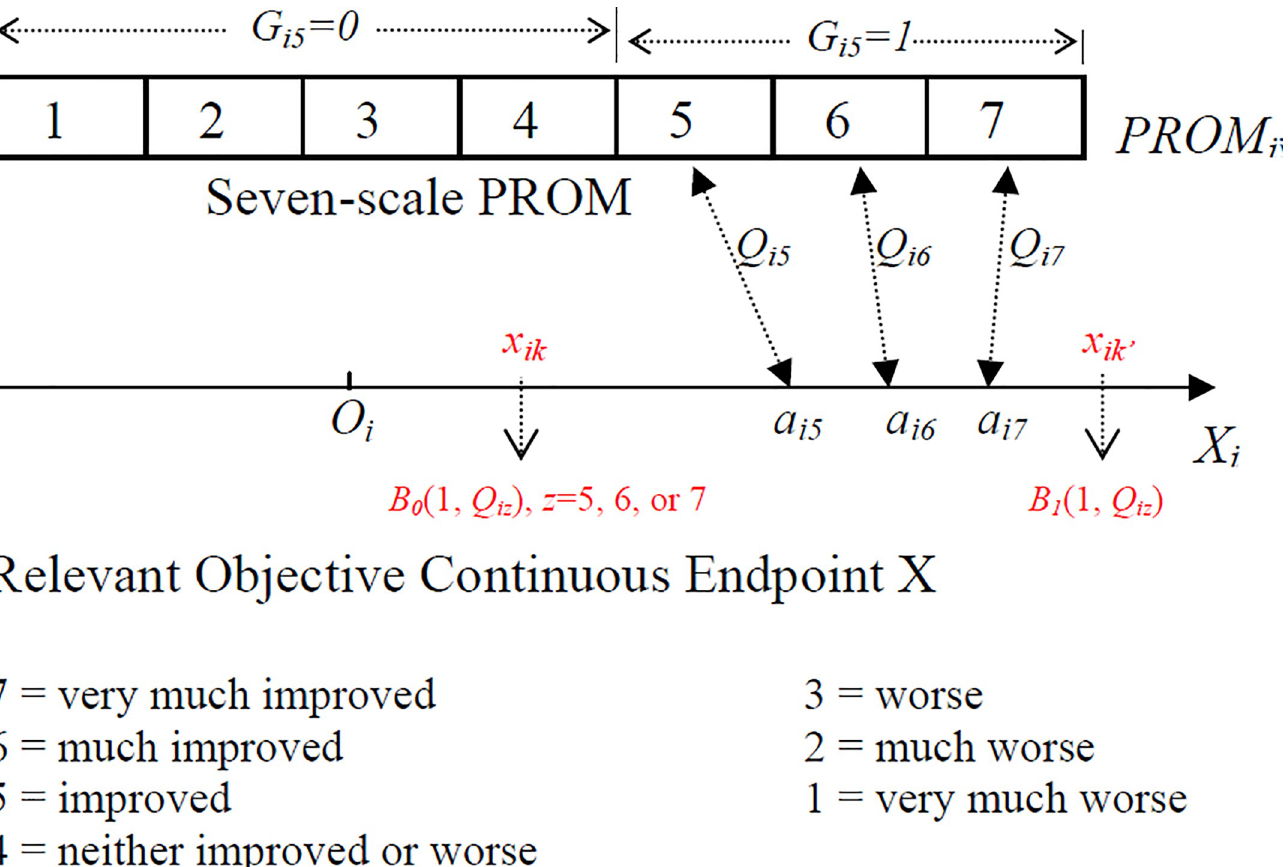
Fig 1. Conditional associations between a PROM and a continuous objective efficacy endpoint X for subject i .